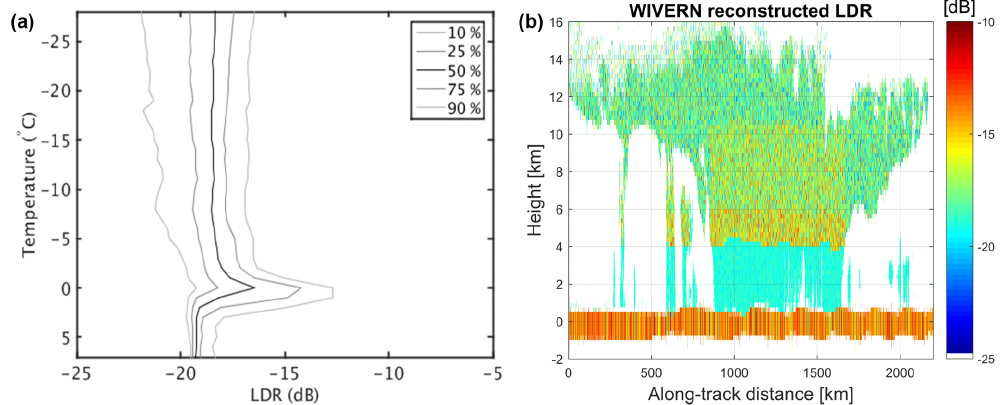
Figure 5. (a) Climatological observations of W-band LDR at the Chilbolton Observatory for an elevation angle of 45 ◦ (courtesy of John Nicol, University of Reading). (b) Simulated LDR for the scene shown in Fig. 3 at CloudSat resolution (1.1km horizontal, 0.5km vertical).